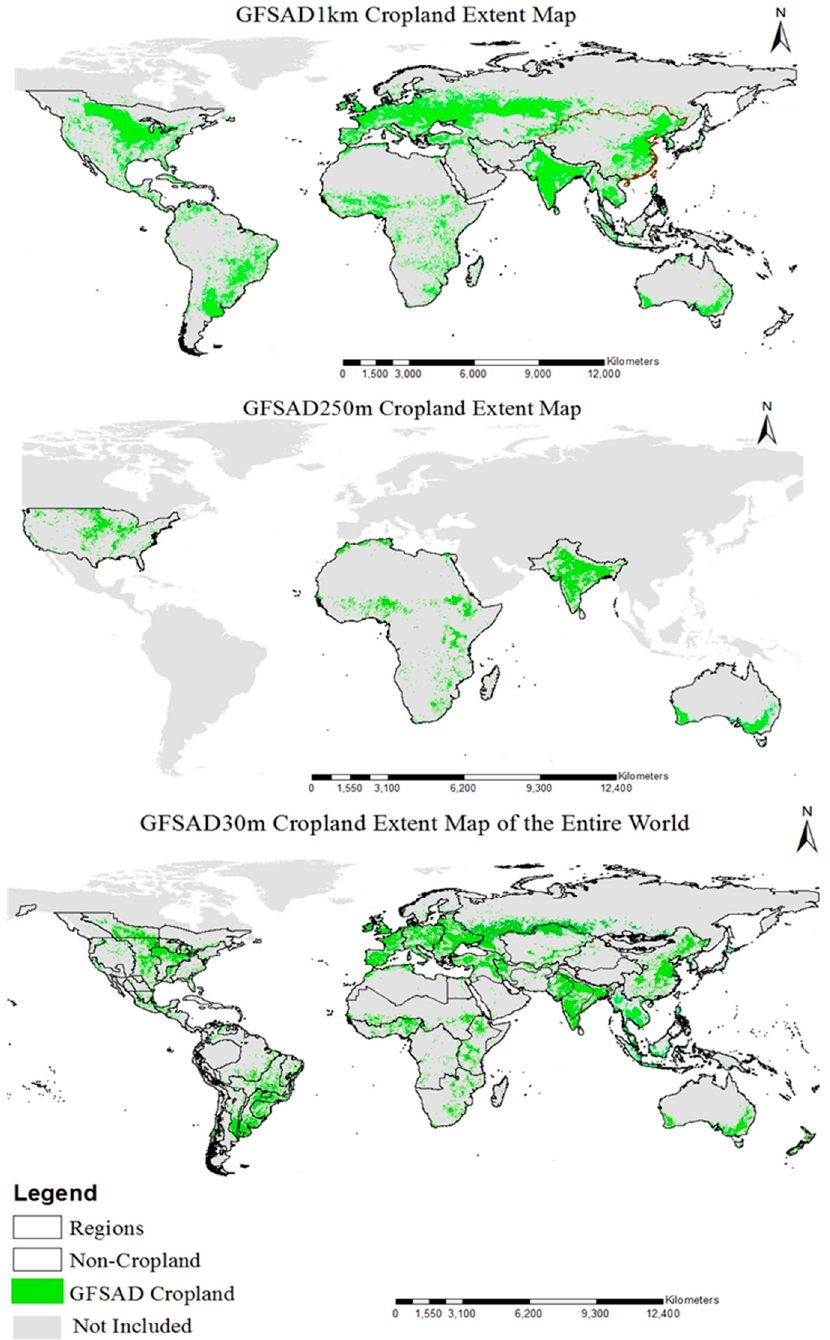
Figure 2. The GFSAD 1 km [5], 250 m [6–8], and 30 m [9–18] cropland extent maps generated by multiple producers.